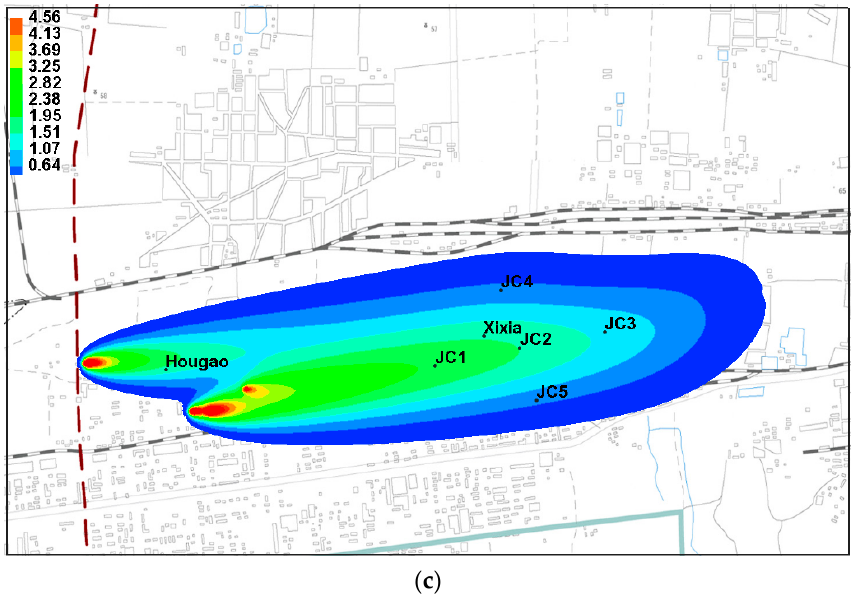
Figure 10. Prediction diagram of ammonia nitrogen transport in the four Hougao wells after pumping is stopped; ( a ) five years; ( b ) ten years; ( c ) twenty years .